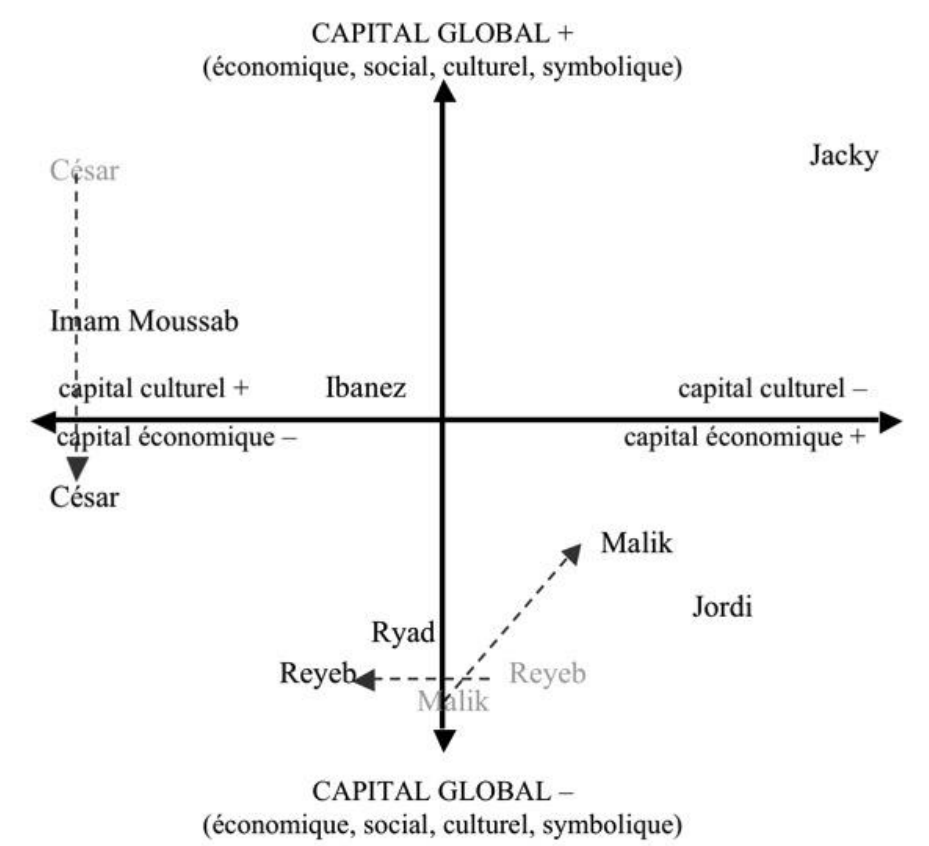
Figure 2 Le mouvement des positions sociales des personnages d’ Un